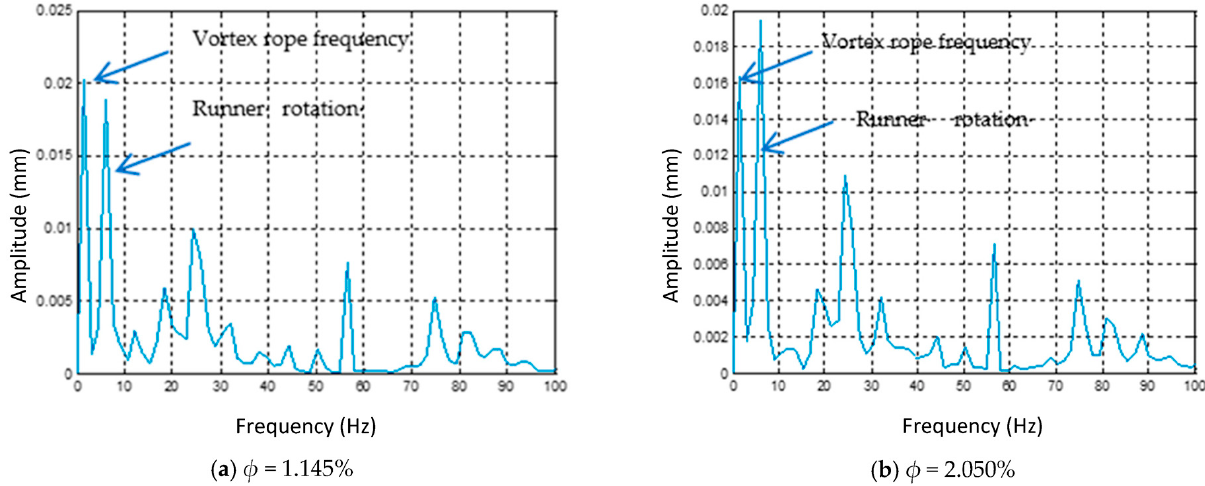
Figure 9. Amplitude spectrum of the vibrations obtained from displacement sensors on radial and axial direction located on the radial–axial bearing ( a ) for the 1.145% void fraction and ( b ) for the 2.05% void